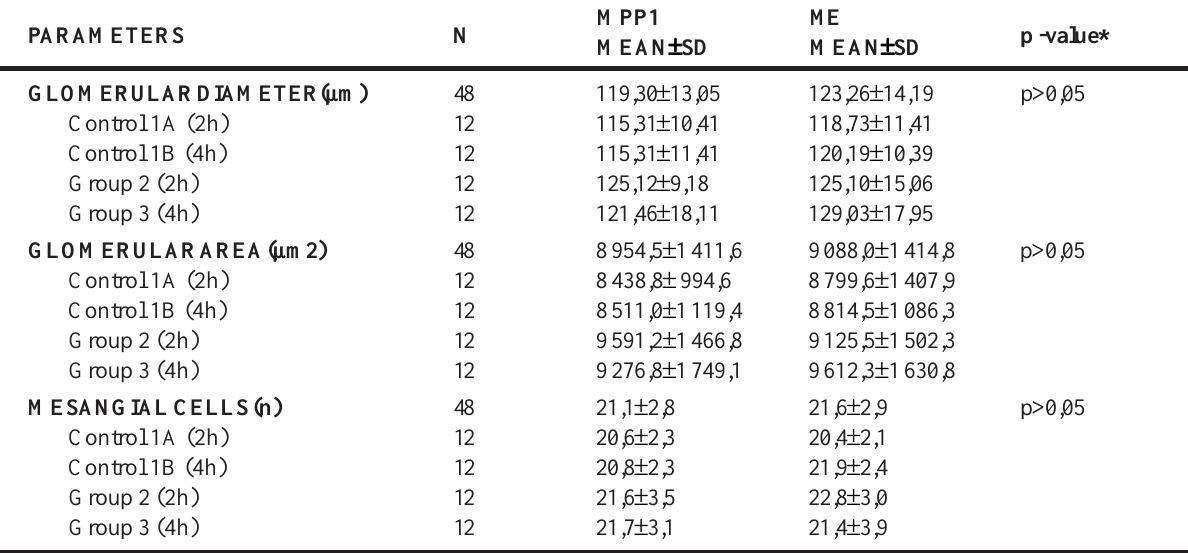
TABLE 2 - Morphometric study among the groups – MPP1/ME